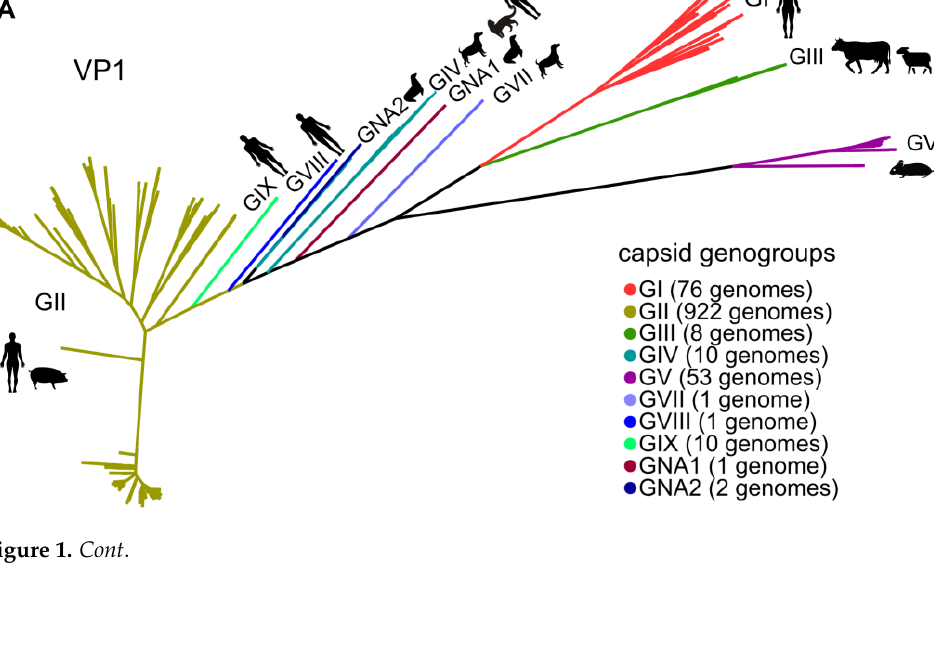
Figure 1. The maximum likelihood tree of the VP1 ( A ) and RdRp encoding ( B ) sequences (N = 1084) of the genus Norovirus . The tree branches are colored according to the capsid genogroup in both trees. The number of sequences in the dataset belonging to each capsid genogroup is indicated in brackets. In the phylogenetic tree for RdRp P-groups are shown. GII.P includes viruses with GII, GVIII and GIX capsid genogroups. The silhouettes of hosts infected by norovirus genogroups are shown near the tips.